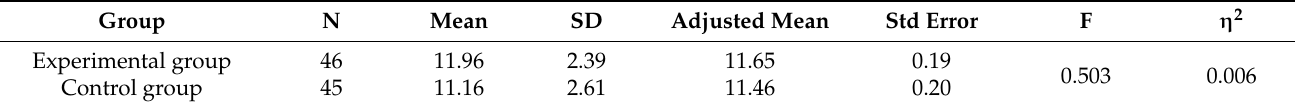
Table 5. The ANCOVA results for cognitive